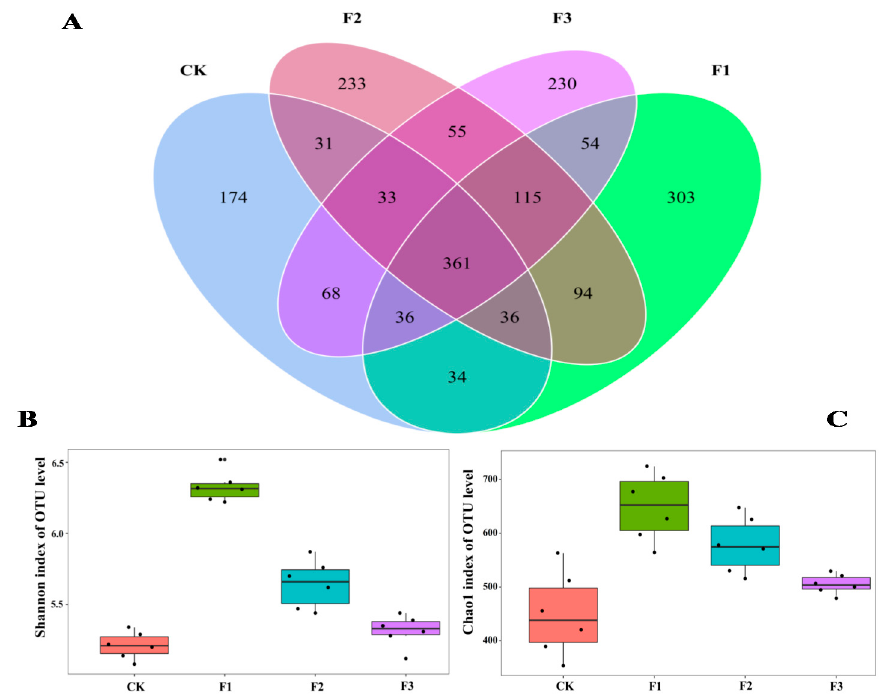
Figure 5. Differences in OTU composition ( A ) and diversity index ( B , C ) of Chinese yam rhizosphere fungi under different foliar fertilizer treatments. Each part in the Venn diagram represents one treatment, and the number of circles and circles overlapped represents the number of OTUs shared between the samples, while the number without overlap represents the number of OTUs unique to the samples. CK, spray with water; F1, NPK foliar fertilizer; F2, NPK+Fe-Mn-Zn foliar fertilizer; F3, Fe-Mn-Zn foliar